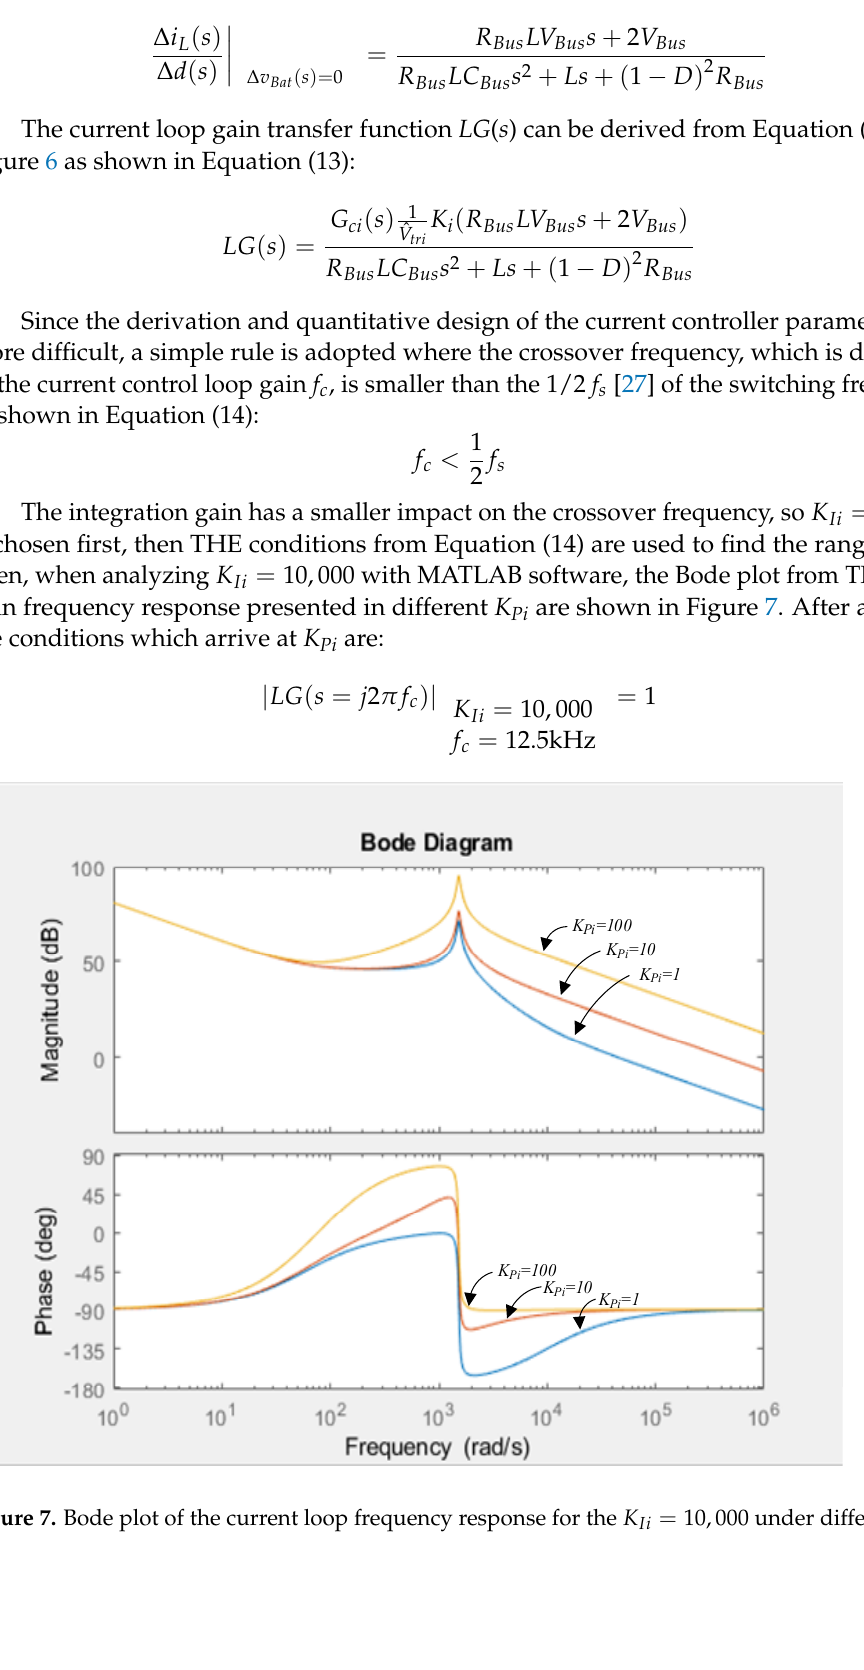
v K pv K Figure 8. Block diagram for the voltage loop control of the bidirectional soft-switching converter. The estimation steps for using the step response estimation method are as follows [27]: (a)